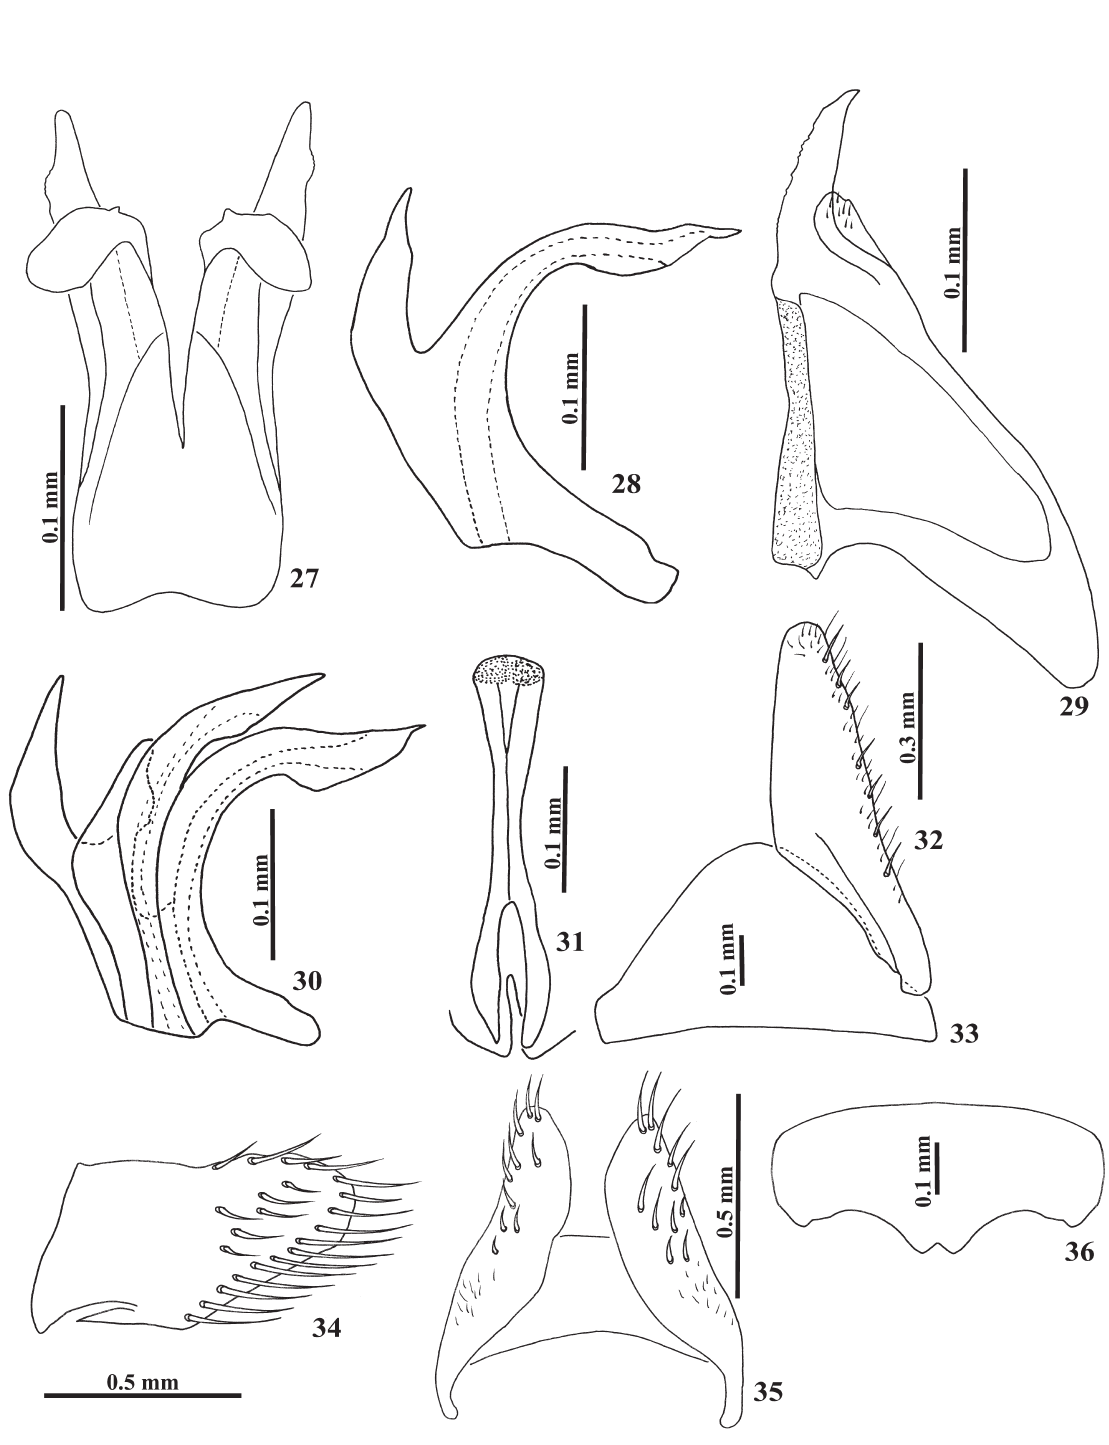
Figs 27–36. Oshaibahus kadiae El-Sonbati & Wilson gen. et sp. nov. 27 . Aedeagus dorsal view. 28 , 30 . Aedeagus lateral view. 29 . Style. 31 . Connective. 32 . Subgenital plate. 33 . Valve. 34 . Lateral view of pygofer. 35 . Ventral view of pygofer. 36 . ♀ 7 th